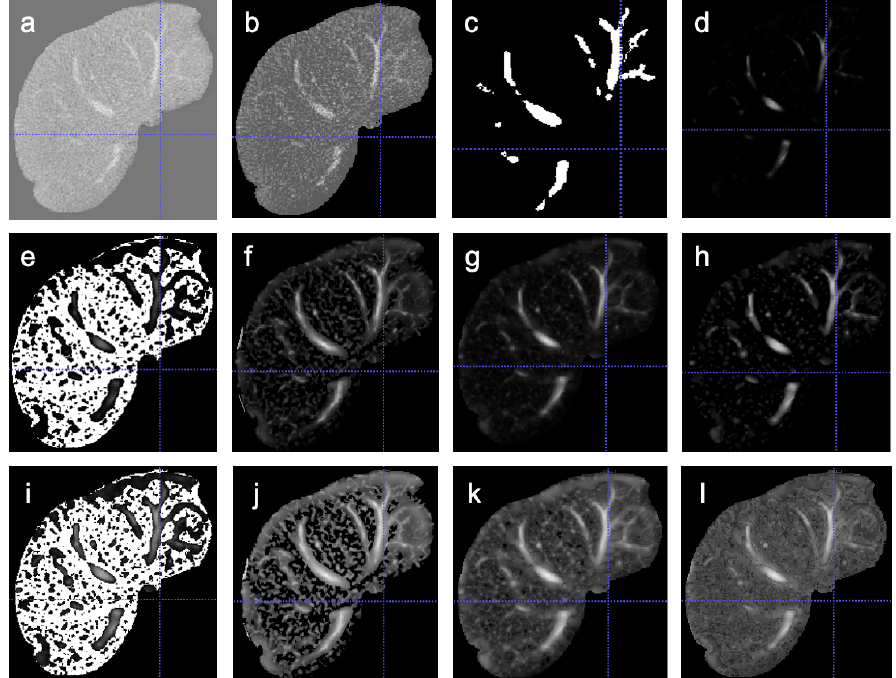
Figure 1. Comparison of different enhancement methods. ( a ) Original image, ( b ) HW, ( c ) Ground truth, ( d ) Frangi, ( e ) Hessian, ( f ) Meijering, ( g ) Sato, ( h ) FrangiGC, ( i ) HessianGC, ( j ) MeijeringGC, ( k ) SatoGC, ( l )